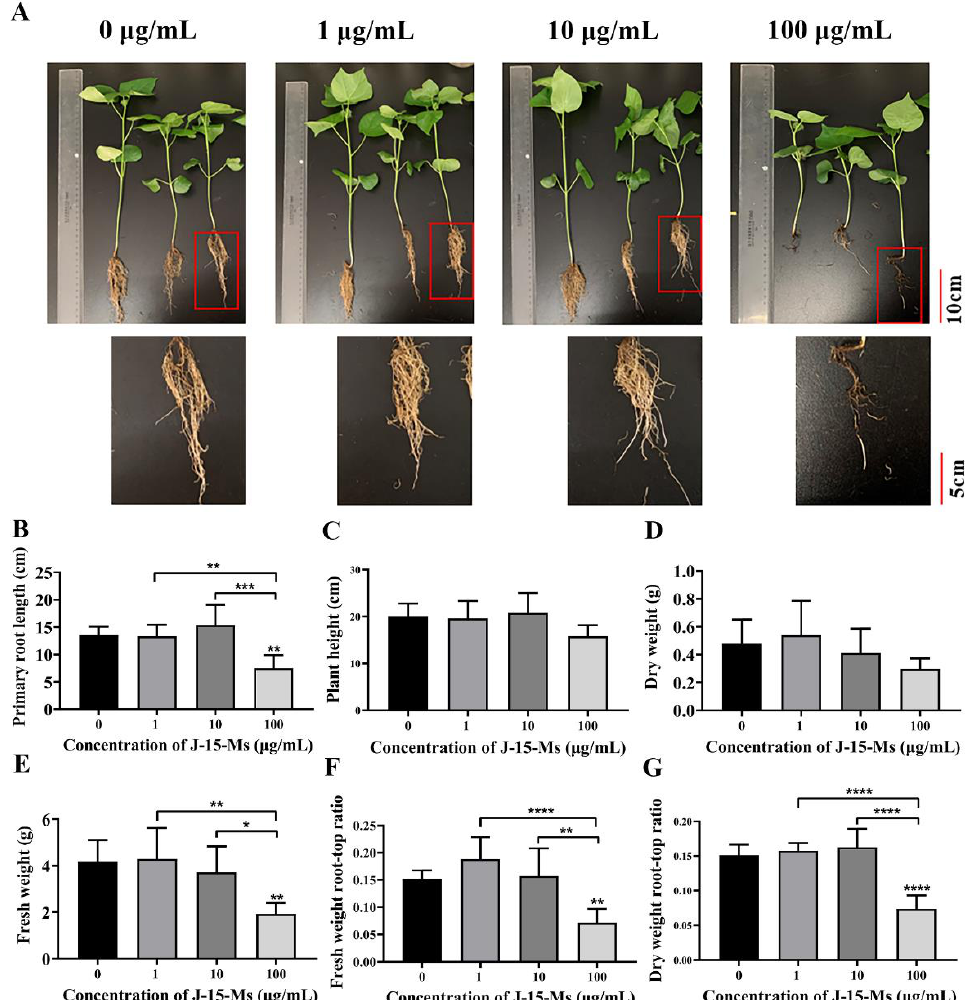
Figure 2. Effects of J-15-Ms on the growth of cotton seedlings. ( A ) Cotton seedling growth phenotype. ( B ) Effect on primary root length. ( C ) Effect on plant height. ( D ) Effect on dry weight. ( E ) Effect on fresh weight. ( F ) Effect on fresh weight root-top ratio. ( G ) Effect on dry weight root-top ratio. Note: Means ± SEs, n = 50, different “*” indicate significant differences among treatments based on the least significant difference at p ≤